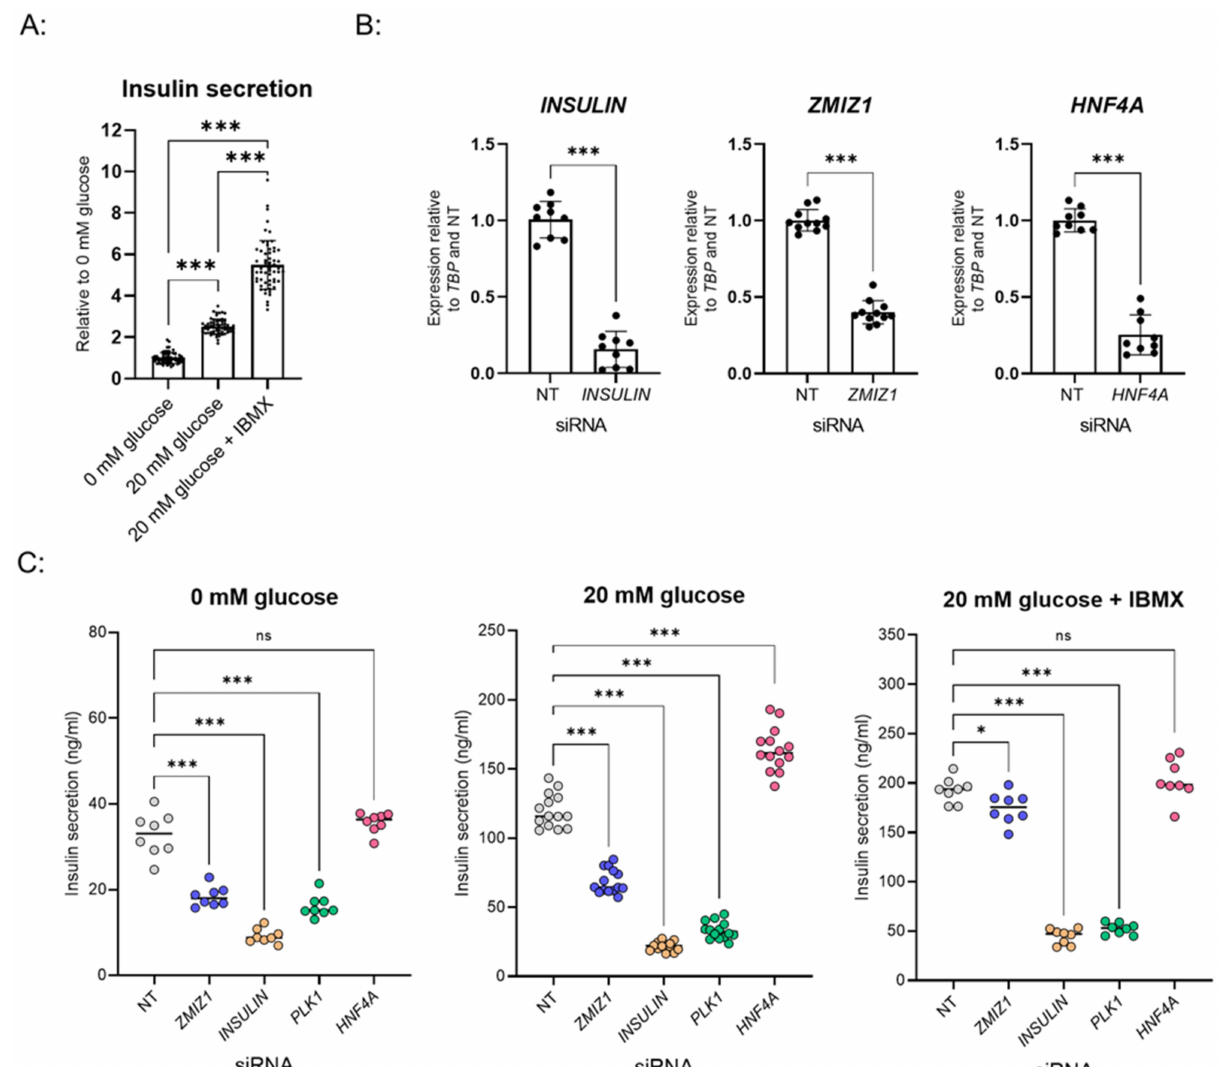
Figure 1. Establishment of siRNA knockdown and GSIS assay in EndoC- β H1 for a high-throughput screen in 384-well format. ( A ) Glucose-stimulated insulin secretion (GSIS) assay in EndoC- β H1 cells cultured in 384-well format. Data points are the mean ± SD of independent wells n = 60 for each condition. *** p -value < 0.001, one-way ANOVA. ( B ) Relative ex-pression of INSULIN, ZMIZ1 and HNF4A after siRNA knockdown in a 384-well format. Data points are the mean ± SD of independent wells from three experiments. *** p -value < 0.001, t -test. ( C ) Effects of control siRNAs (non-targeting [NT] control, ZMIZ1, INSULIN, PLK1, HNF4A) on GSIS in EndoC- β H1 cells in 384-well format. Data points are the mean ± SD of independent wells n = 8 for 0 mM glucose and 20 mM glucose + IBMX, n = 14 for 20 mM glucose from one experiment. ns (non-significant) p value > 0.05, * p -value < 0.05, *** p -value < 0.001, one-way